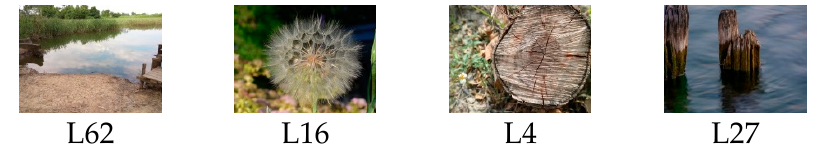
Figure 8. Recommended pictures with the grey relational grade >0.8, but not all adjective grey relational coefficients >0.8.